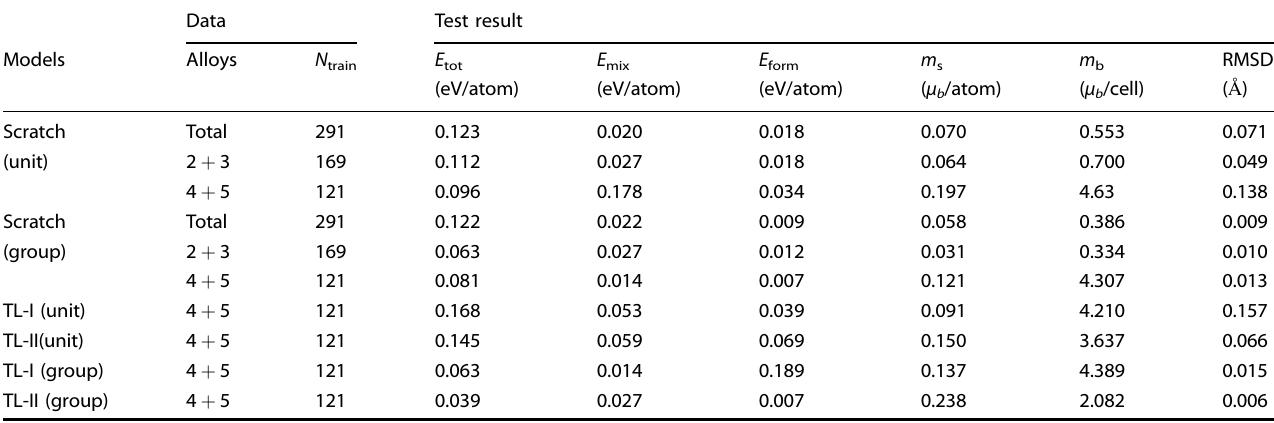
Table 2. Statistical summary of the prediction performance (MAEs) of six different properties on test